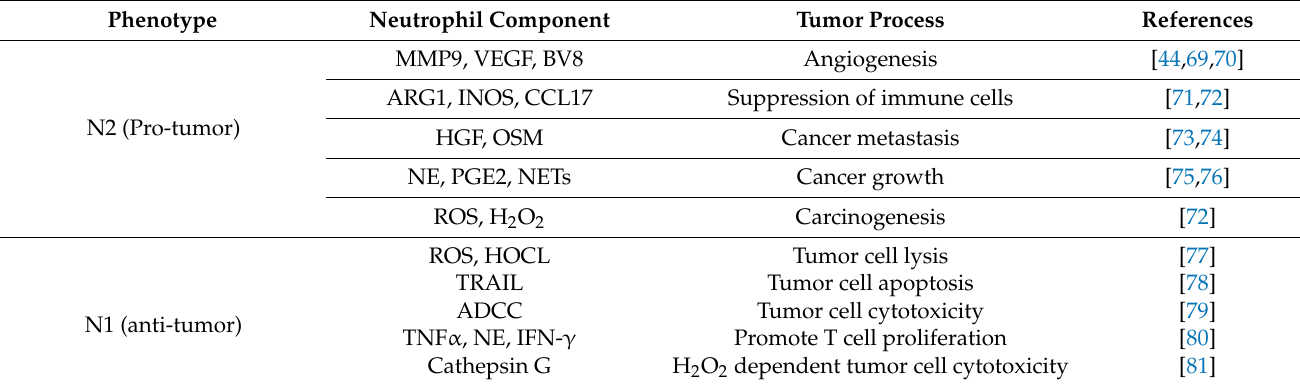
Table 2. Pro and anti-tumor properties of neutrophils and their role in tumor